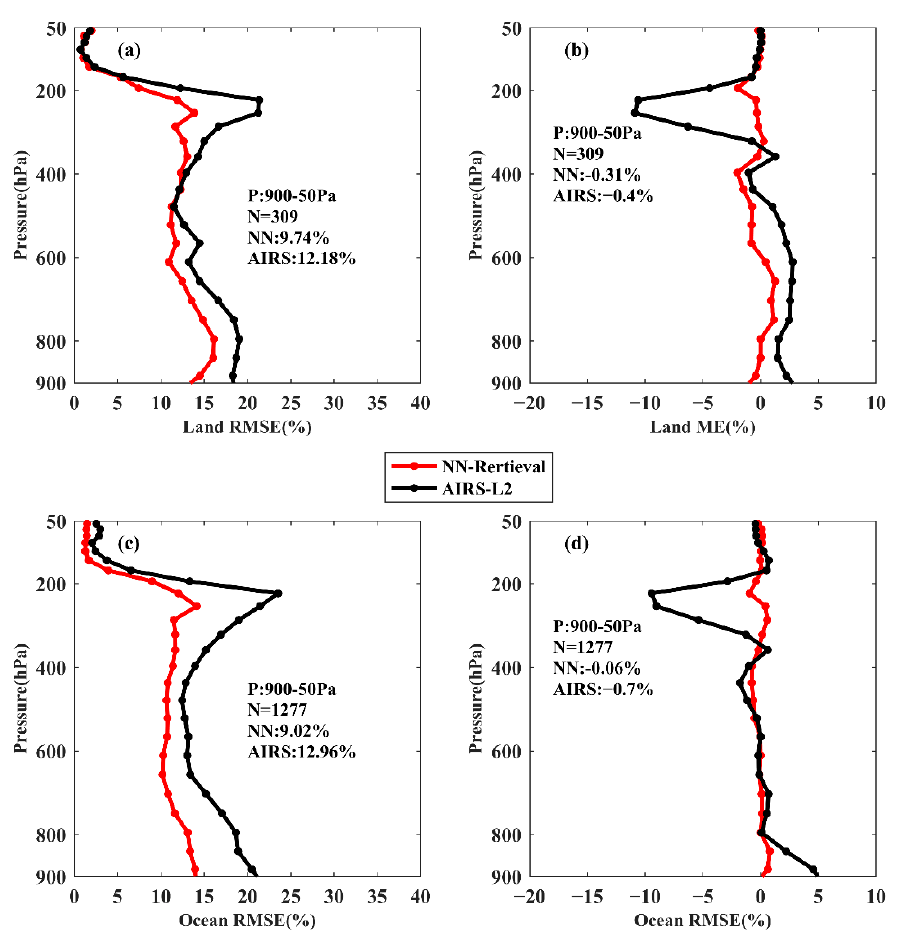
Figure 11. Accuracy comparisons between Aqua/AIRS-L2 RH products and NNs retrievals versus ERA5. ( a , b ) The RMSE and ME of RH on land, respectively; ( c , d ) the RMSE and ME of RH on ocean, respectively. The red dotted line represents the comparison between the retrievals from NNs and ERA5 data, the black solid line represents the comparison between AIRS products and the ERA5 data.